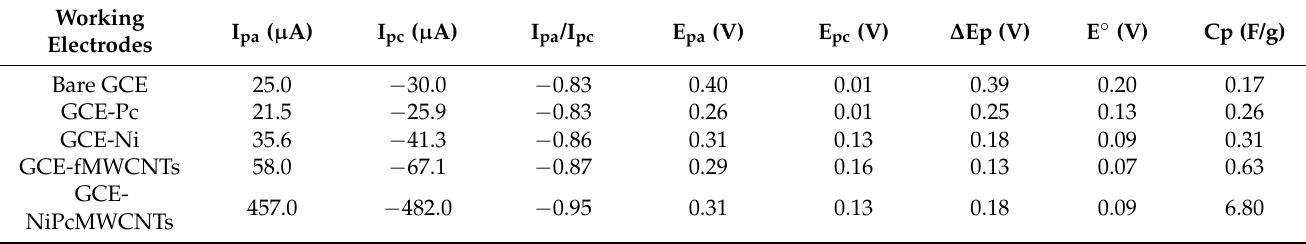
Table 1. Summary of CV Results of Bare and Modified Electrodes in 5 mM [Fe(CN) 6 ] 3 − /4 − Prepared in 0.1 M PBS at pH 7 (Scan Rate, 25 mVs − 1